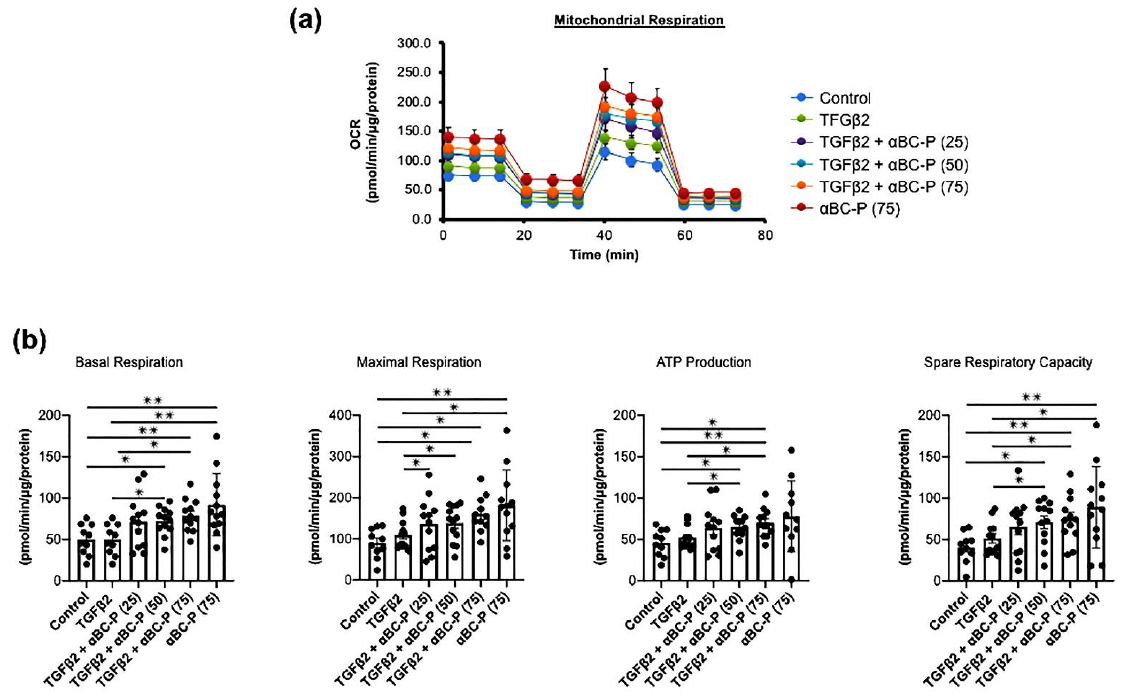
Figure 5. Increased respiration and ATP production in EMT and further activation by α BC-P. Mito-